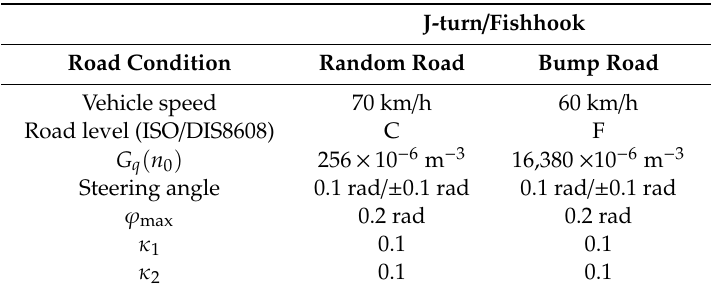
Table 6. The related parameter settings of di ff erent conditions.